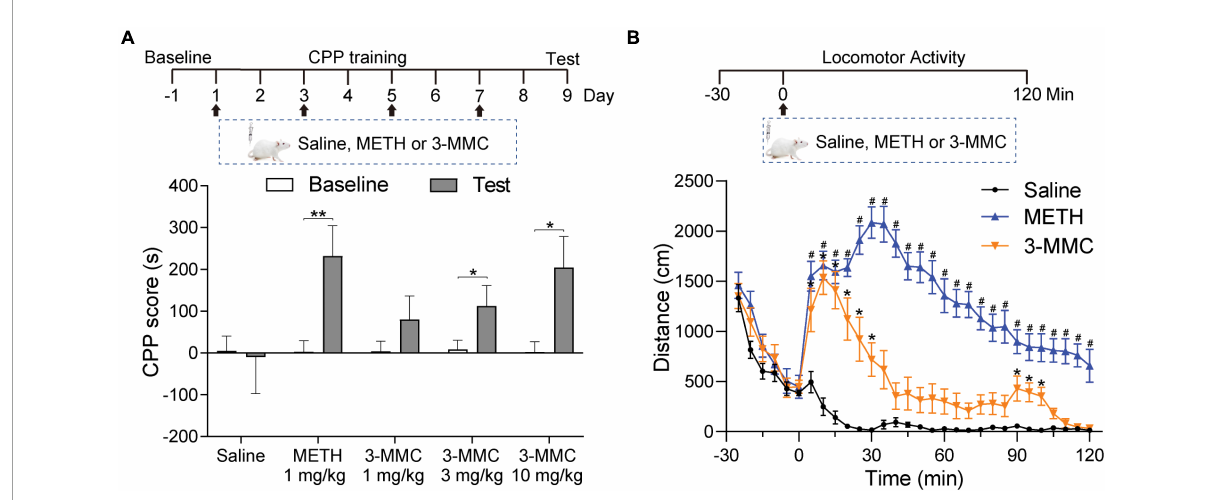
FIGURE1 The effects of 3-MMC on CPP and locomotor activity. (A ) Experimental timeline showing the CPP training. The rats trained with saline, METH (1 mg/kg) or 3-MMC (1, 3, or 10 mg/kg) for 8 days and tested in day 9, paired t -test, * P < 0.05, ** P < 0.01 significant differences for each drug in CPP test, n = 10 for each group. (B) A single injection of 3-MMC (3 mg/kg) or METH (1 mg/kg) increased locomotor activity. Each point represents the average distance traveled in 5-min bins. Saline, Meth and 3-MMC group, post hoc test, * P < 0.05 significant differences in distance for 3-MMC vs saline, # P < 0.05 significant differences for METH vs saline, n = 8, 9, and 8, respectively. Data are presented as mean values ±